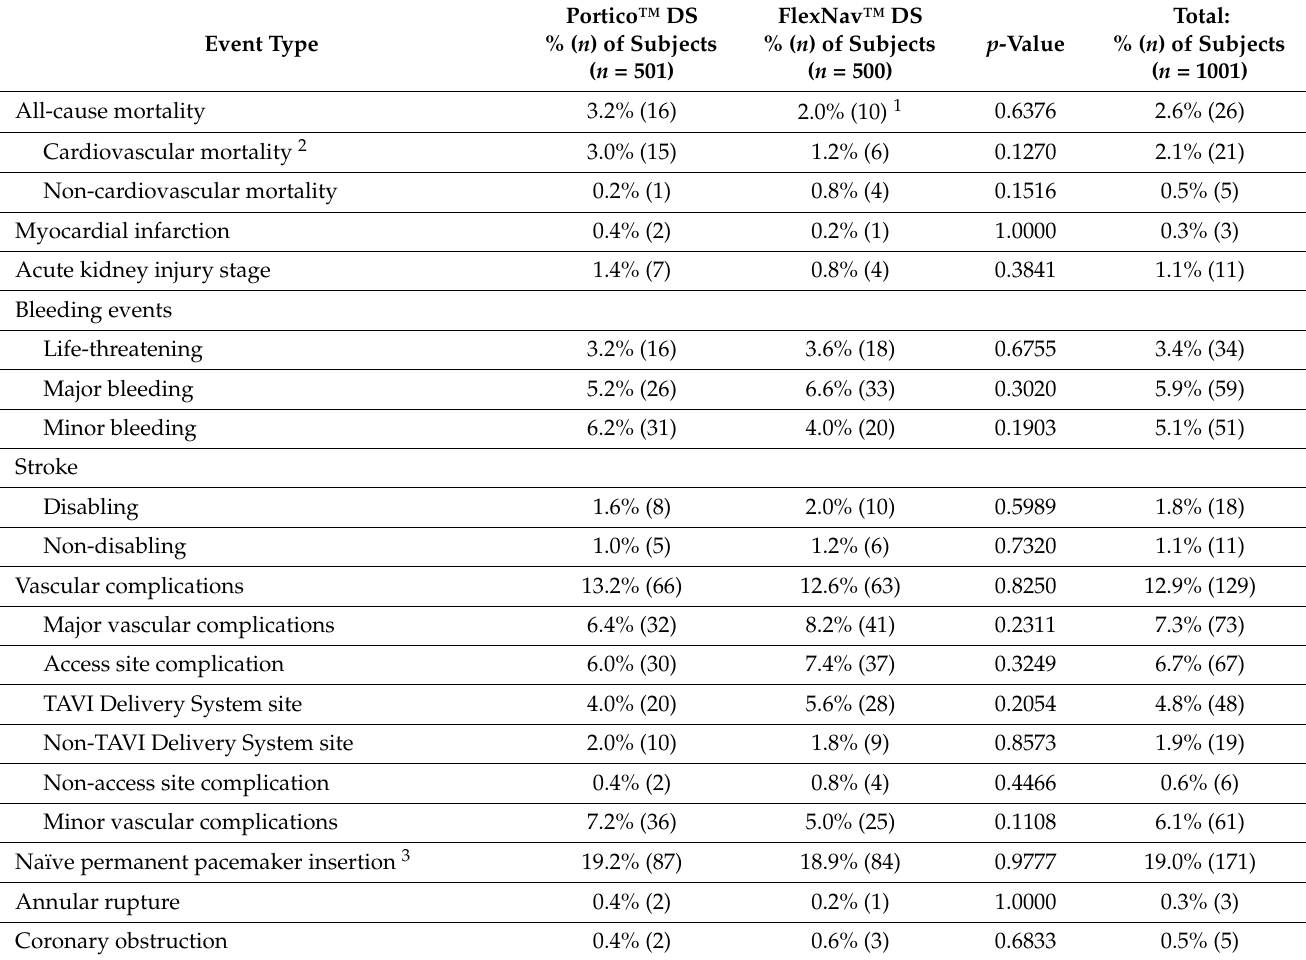
Table 3. The 30-day